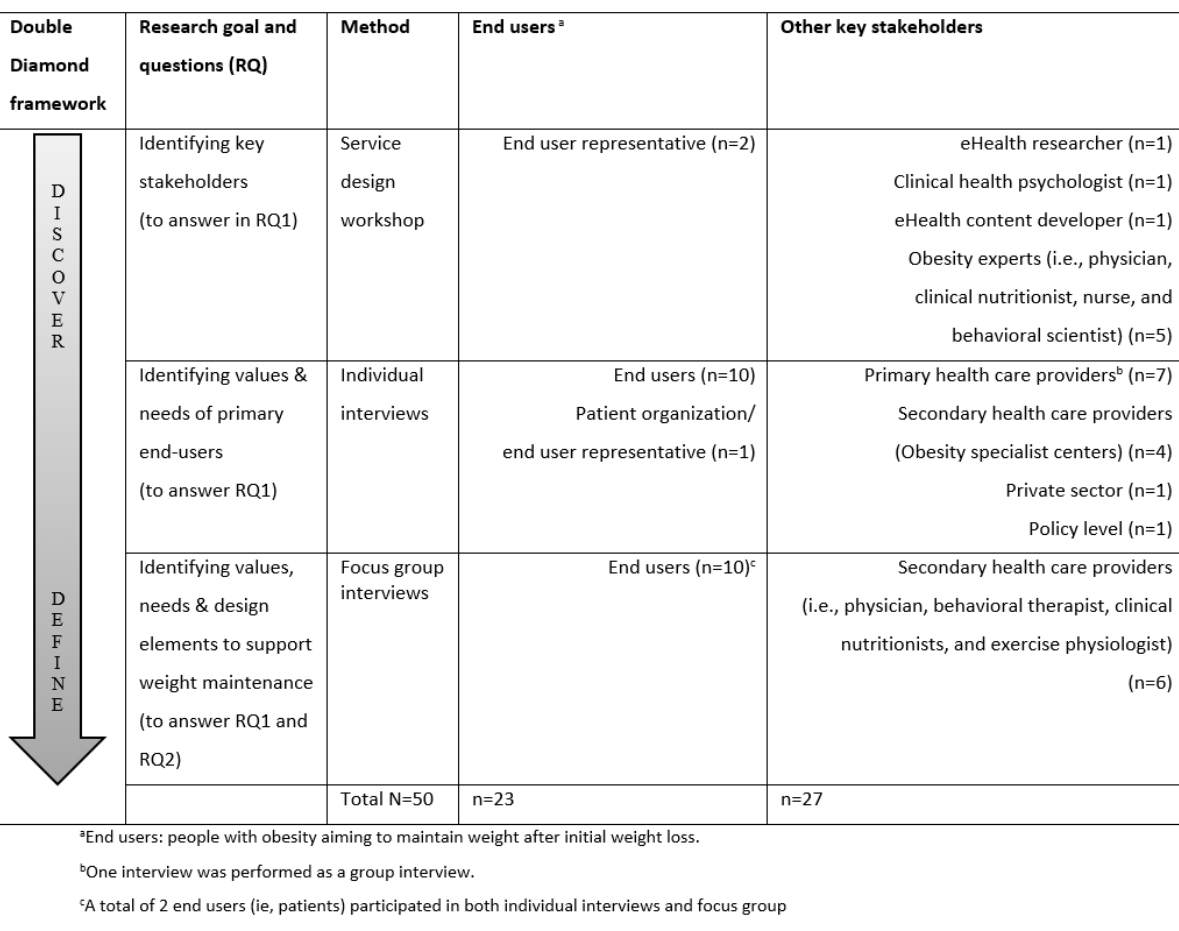
Figure 2. Study participants and data